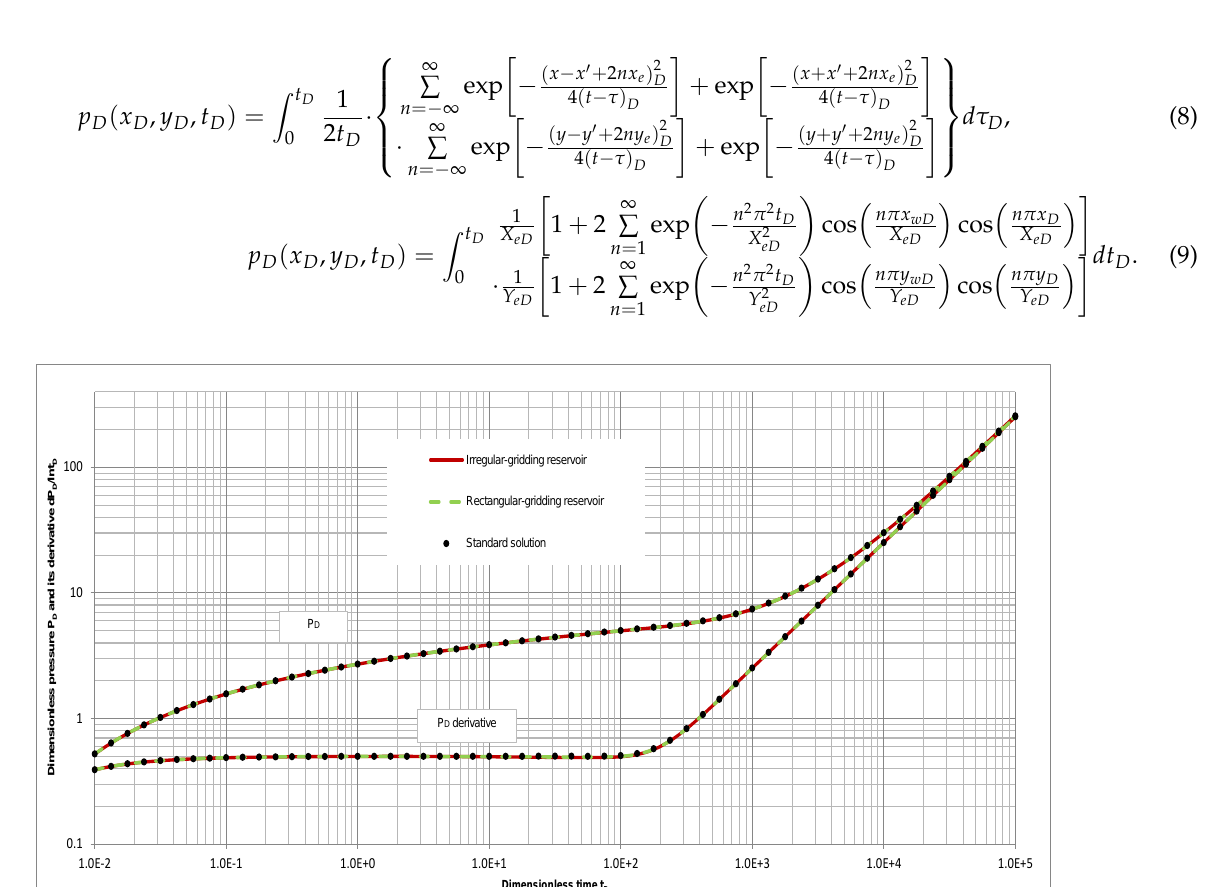
Figure 4. Standard solutions to reservoir schematics in Figure 3a,b under homogeneous reservoir condition, 𝑋 𝑒𝐷 = 50 and 𝑌 𝑒𝐷 = 50 .